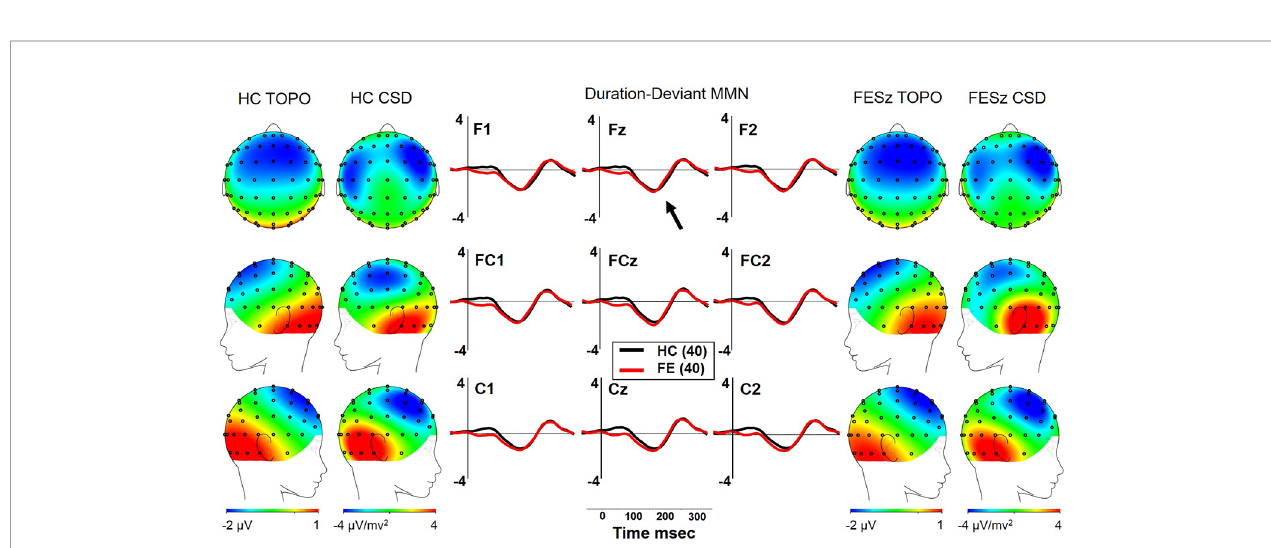
FIGURE 4 | dMMN in the fi rst episode schizophrenia spectrum. HC, Healthy Control subjects; FESz, First Episode Schizophrenia Spectrum subjects; Topo, Voltage topography; CSD, Current Source Density topography.